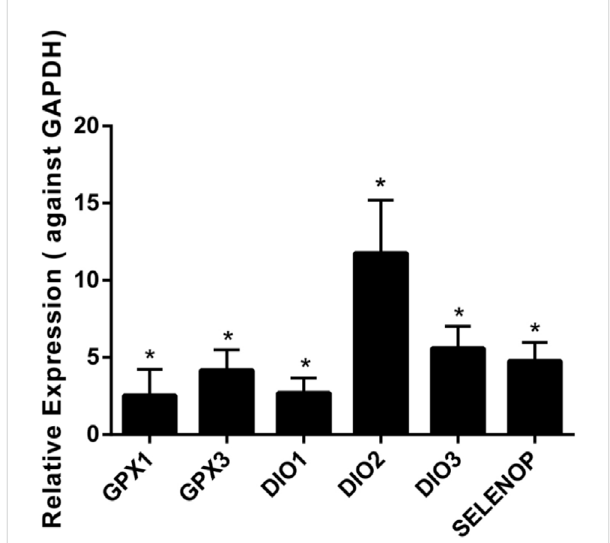
FIGURE 1 Differentially expressed gene expression of selenoproteins in chondrocytesofKBDpatients( n =3)andnormalcontrols( n =3)using qRT-PCR. * p <